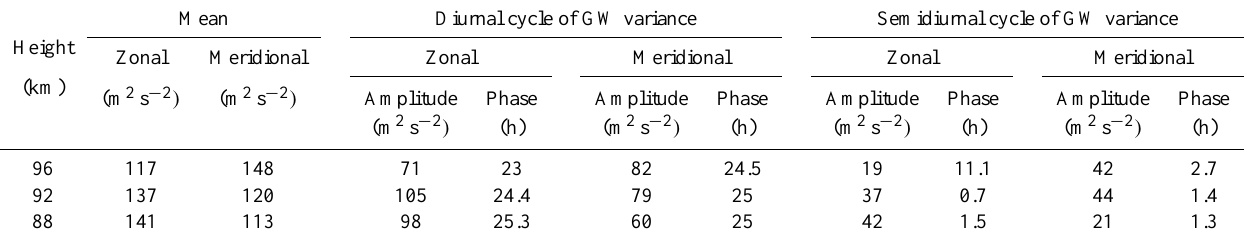
Table 1. Amplitudes and phases of diurnal and semidiurnal cycles of GW variance.